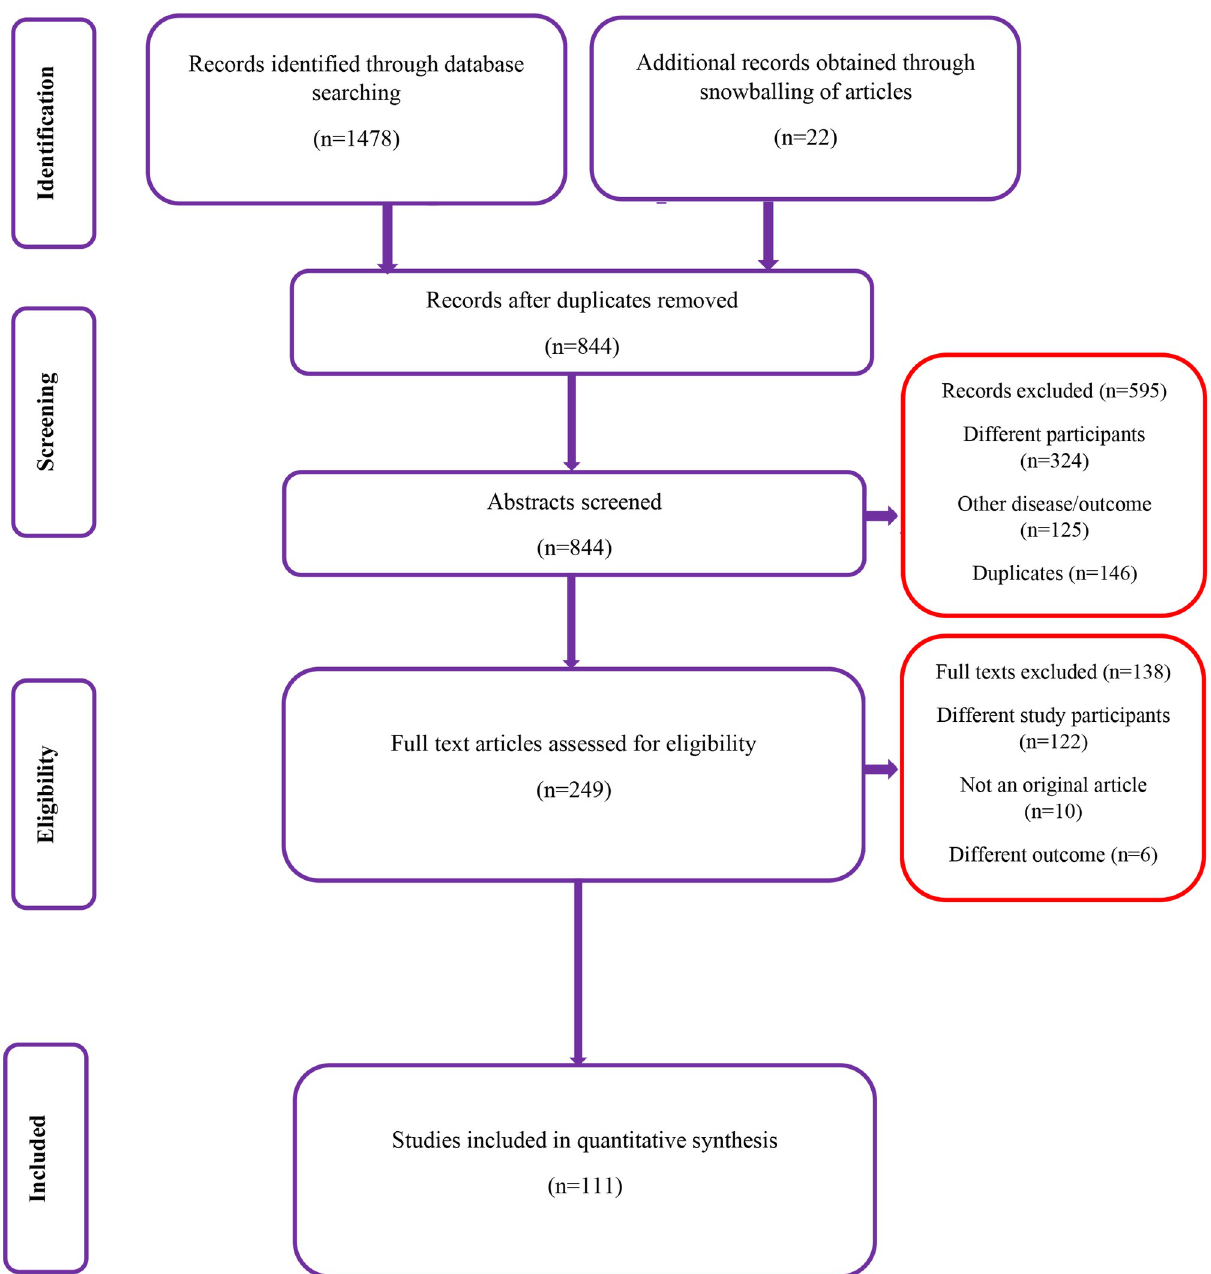
Fig 1. Flow chart showing the search strategy and selection of